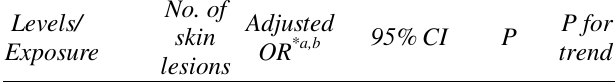
used well for 15 years more (OR=2.30, 95% CI: 0.58-9.14), compared with those who used their well less than 5 years. Multivariate-adjusted Odds Ratios, from logistic regression analysis, for levels arsenic exposure and skin lesions No. Levels/ Exposure